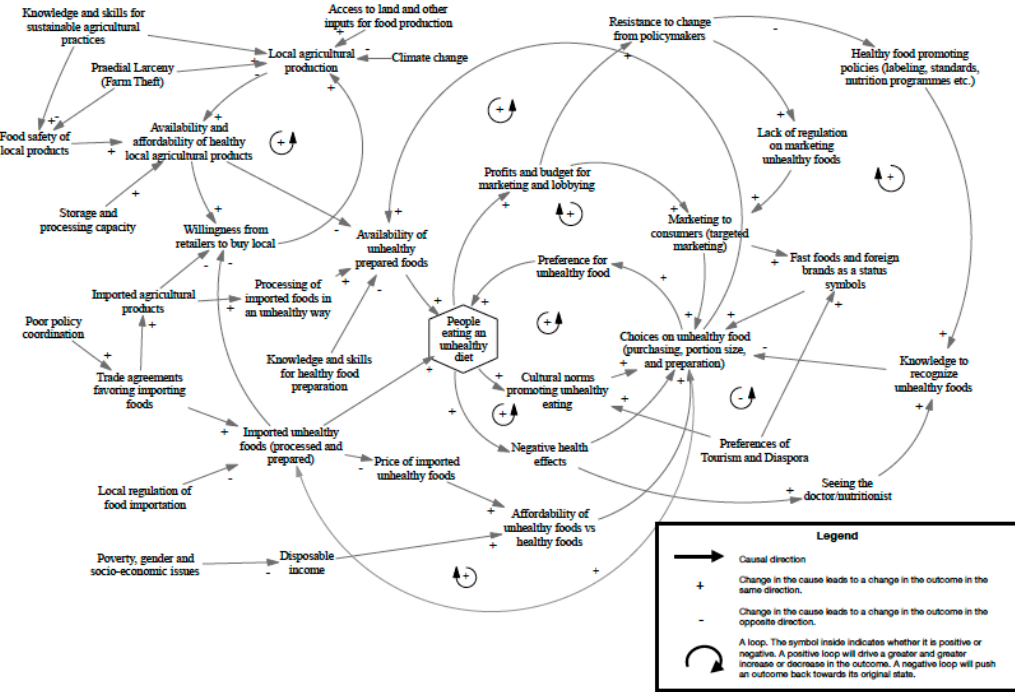
Figure 2. Causal map of unhealthy diet generated from group model building in Jamaica.